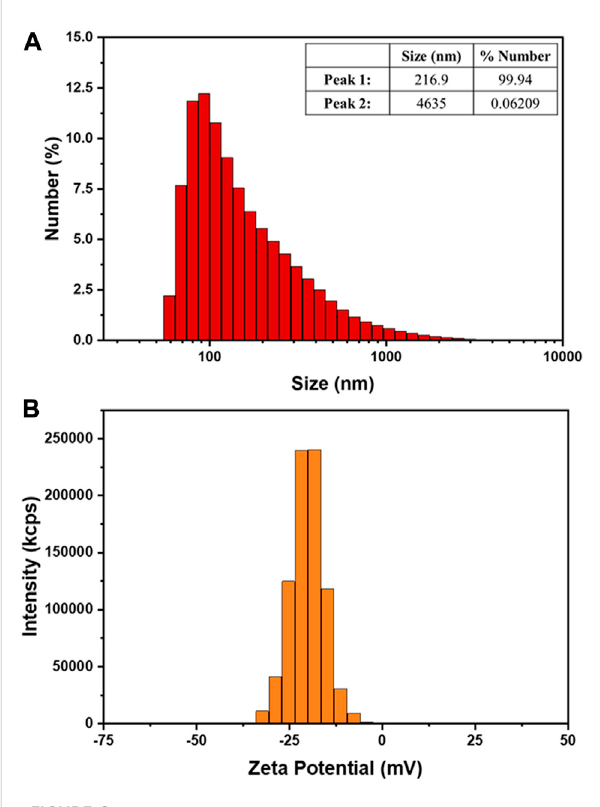
FIGURE 6 (A) Particle size distribution of ozone NB, and (B) Zeta potential value of ozone